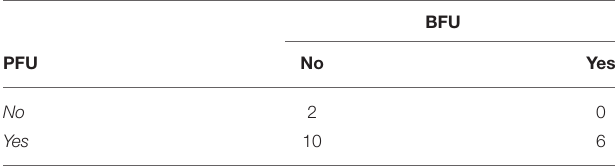
TABLE 4 | Numbers of subjects experiencing or not PFU and/or